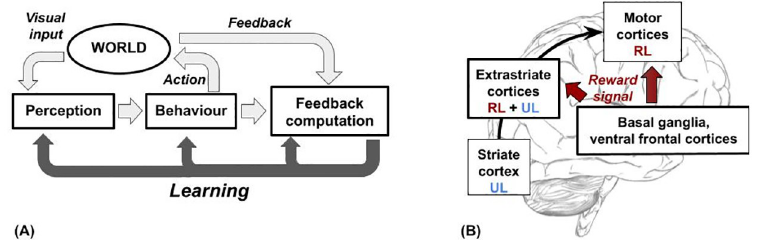
computational model presented here. The intermediate sensory-motor layers (extrastriate cortices) undergo both associative unsupervised learning (UL) and trial-and-error learning (RL). The latter presents a gradient having a decreasing strength moving from the motor cortex towards the striate